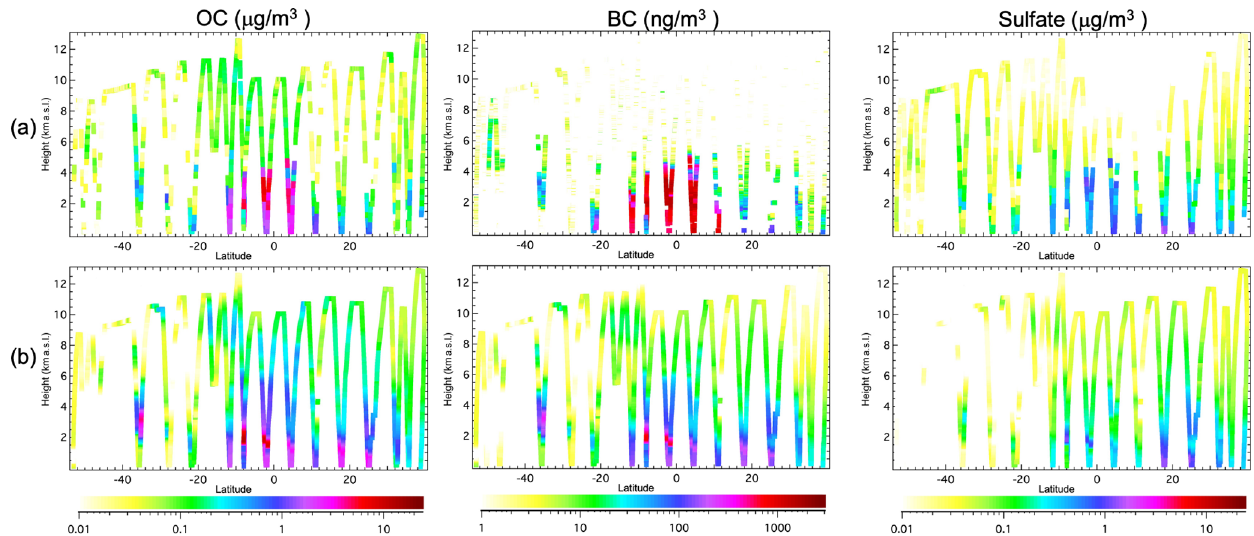
Figure 18. Height–latitude profiles of OC, BC, and sulfate over the Atlantic on 15 and 17 August 2016 for (a) the ATom-1 DC-8 observations and (b)